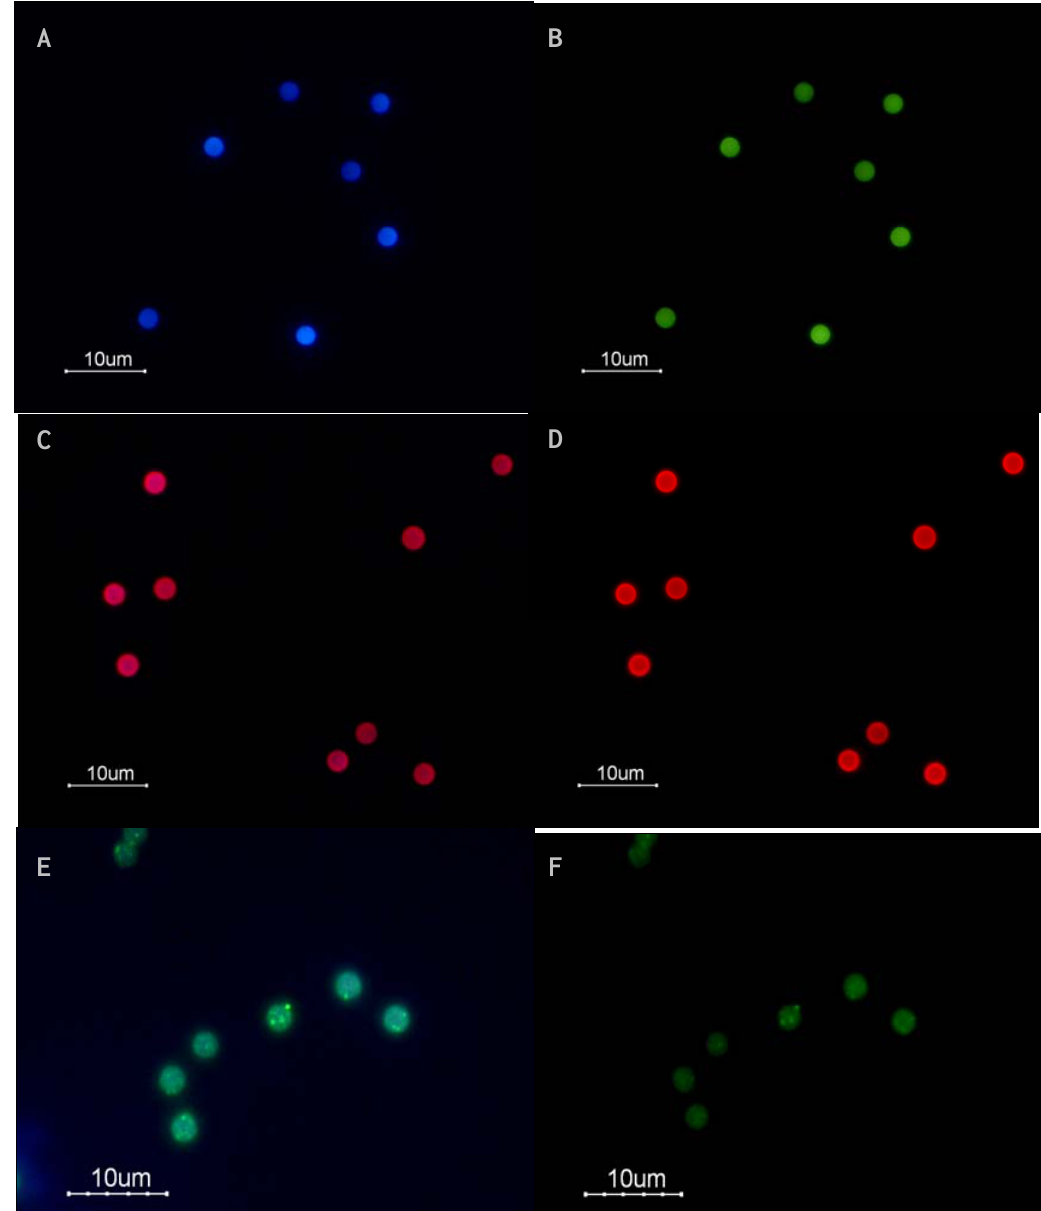
Figure 6. Images of unlabelled beads and QD-bead complexes observed under UV and blue light by epi-fluorescence microscopy. A: Unlabelled beads under UV light. B: Unlabelled beads under blue light. C: QD655-bead complexes under UV light exhibiting a bright red fluorescence. D: QD655-bead complexes under blue light also exhibit a shift to red fluorescence. E: Hops-Yellow QD-bead complexes under UV light exhibited green fluorescence and clusters of yellow fluorescence due to agglomeration of the QDs. F: Hops-Yellow QD-bead complexes under blue light also exhibit green and yellow